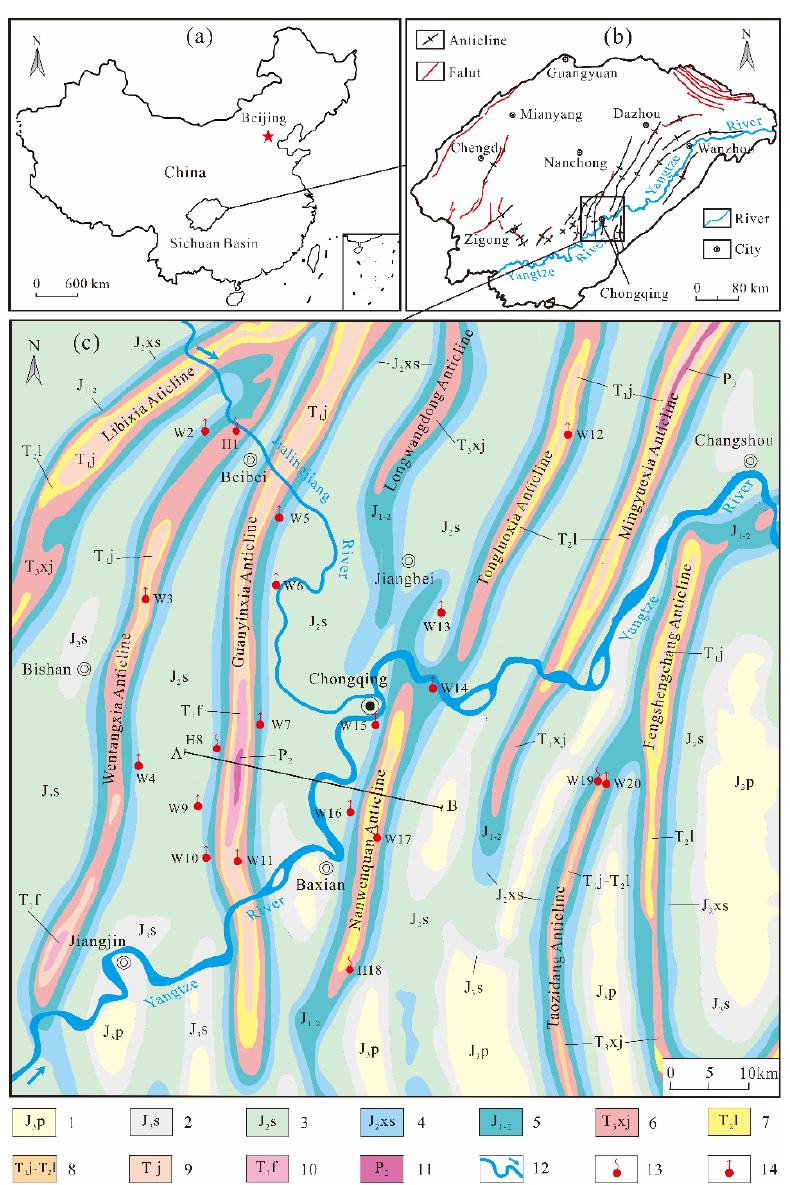
Figure 1. ( a ) Location of the Sichuan Basin; ( b ) Location of the study area; ( c ) Geology and sample locations of the study area. Legend: 1. Quartz sandstones of the Upper Jurassic Penglaizhen Group; 2. Sandy mudstones of the Upper Jurassic Suining Group; 3. Sandy mudstones of the Middle Jurassic Shangshaximiao Group; 4. Shale and sandy mudstones of the Middle Jurassic Xiashangshaximiao Group; 5. Mudstone of the Lower and Middle Jurassic; 6. Feldspathic detritus quartz sandstone of the Upper Triassic Xujiahe Group; 7. Dolomite of the Middle Triassic Leikoupo Group; 8. Limestones of the Lower Triassic Jialingjiang and Middle Triassic Leikoupo Groups; 9. Limestones of the Lower Triassic Jialingjiang Group; 10. Marls of the Lower Triassic Feixianguan Group; 11. Chert nodule limestone of the Upper Permian; 12. River; 13. Hot spring; 14. Geothermal